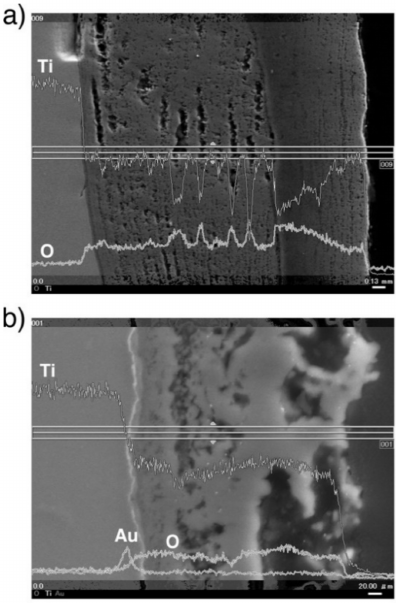
Figure 8. BSE image and line profiles of Au, O, and Ti of the cross-section at the interface of oxidized CP Ti ( a ) without marker insertion and ( b ) with Au marker insertion. The oxidation conditions at 1273 K for 1.8 ks in